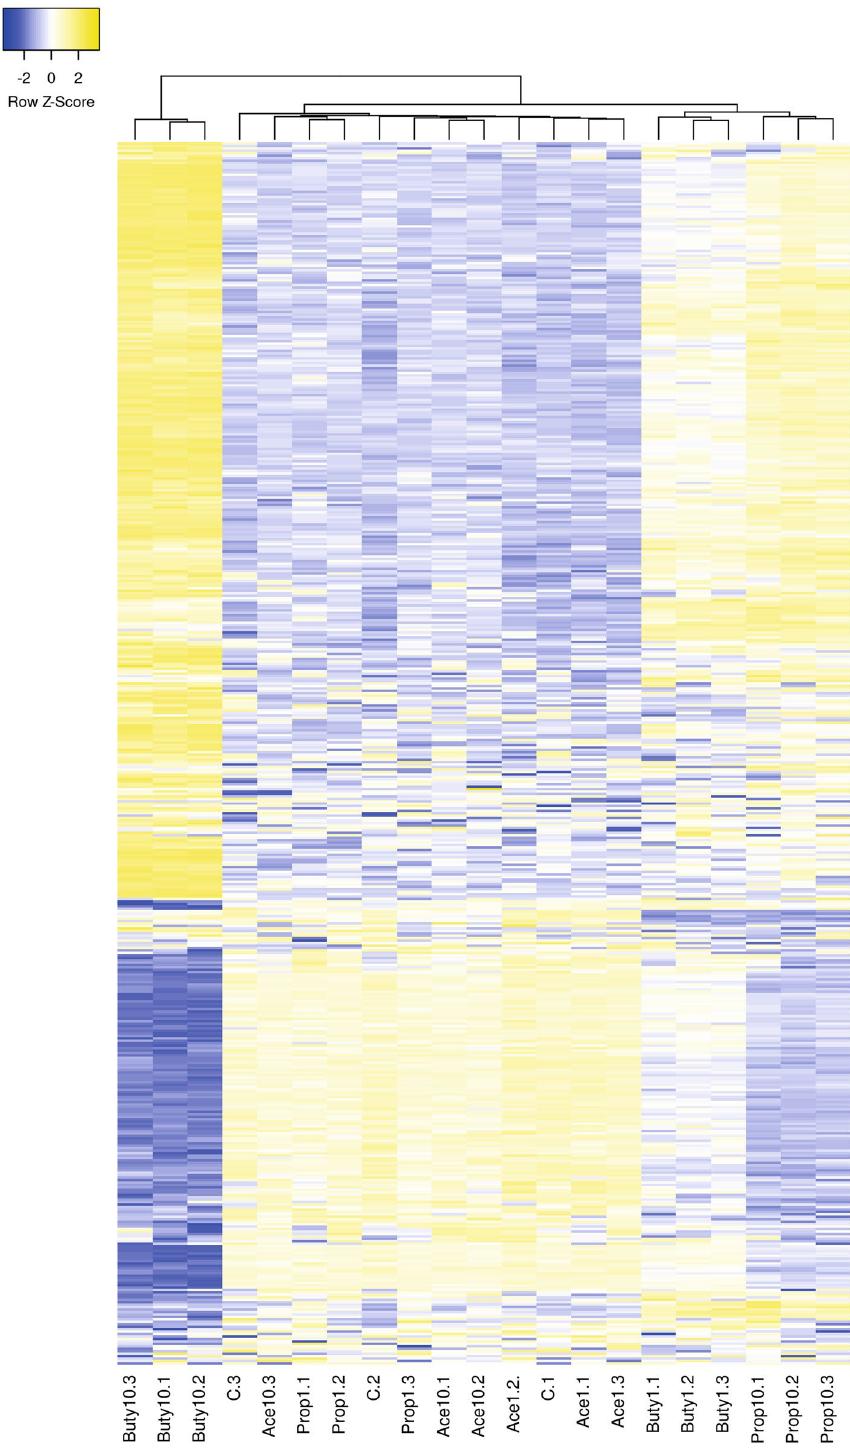
Figure 3. Heatmap of the top 500 differentially expressed genes in induced pluripotent stem cell derived intestinal epithelial cell layers exposed to 1 or 10 mM butyrate (Buty), propionate (Prop) or acetate (Ace) and in the control samples (C) with 3 samples per condition. Blue indicates below average expression and yellow indicates above average expression. Made using heatmapper, http:// www. heatm apper. ca 43,49